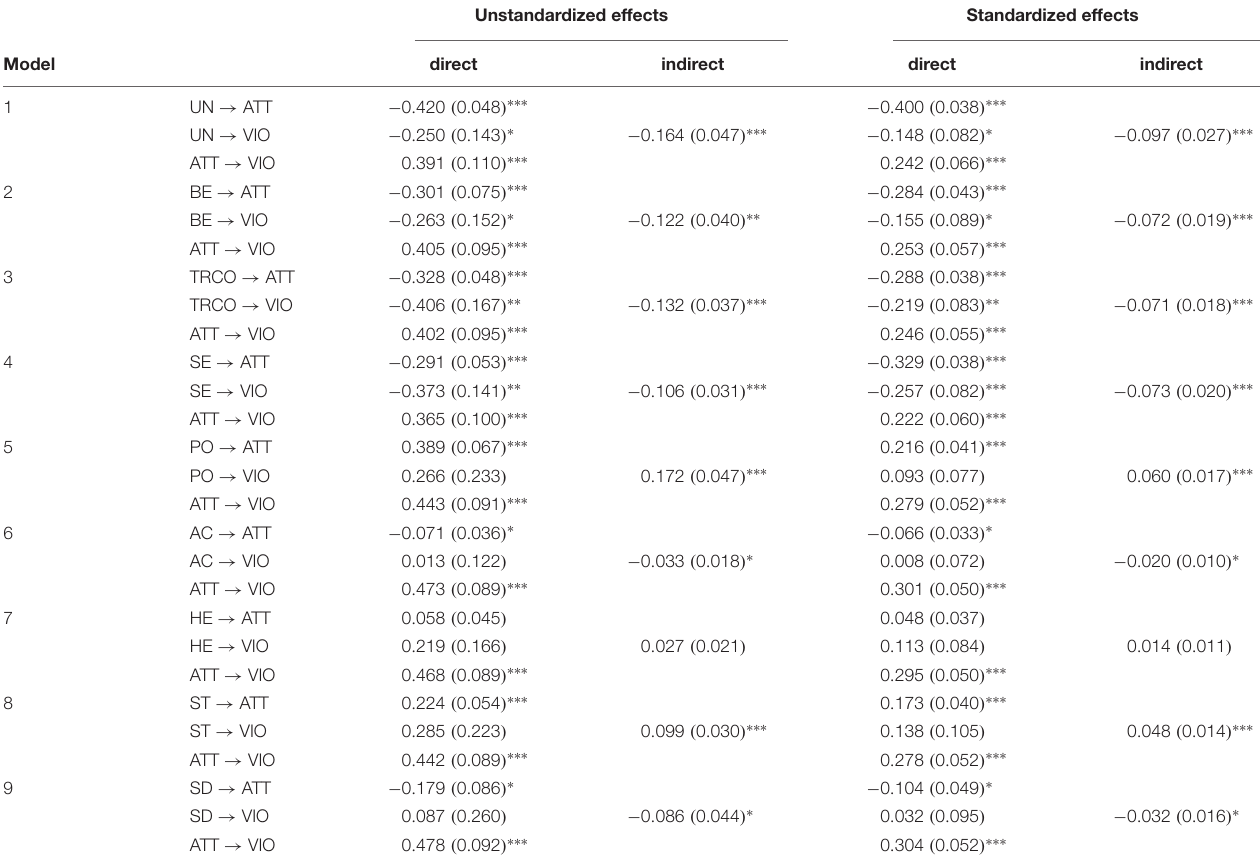
TABLE 4 | Structural equation modeling results for value-specific